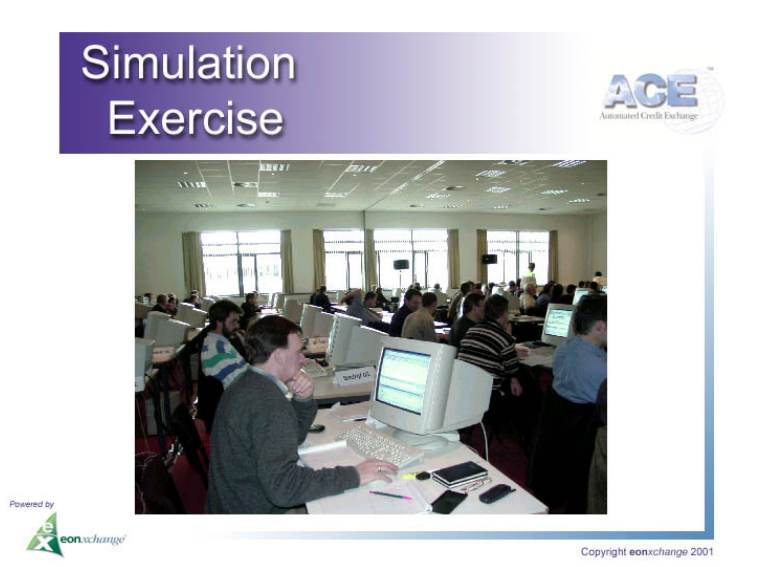
FIGURE 8. Simulation